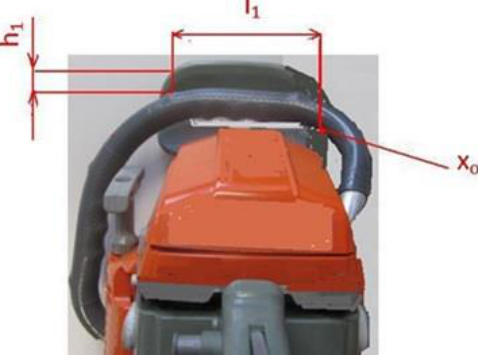
Figure 5. Determination of effective front guard width with hand brake disengaged. l 1 = 100 mm, h 1 = 20 mm: front guard height above the front handle; Xo: reference point.